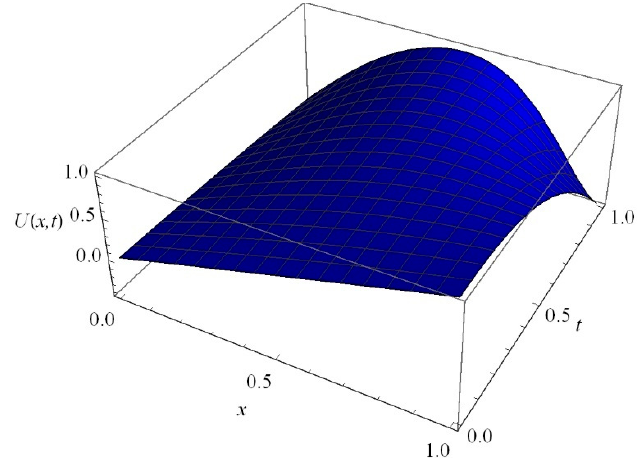
Figure 14. The graph of U ( x , t ) versus depth x and time t for Equation (45).